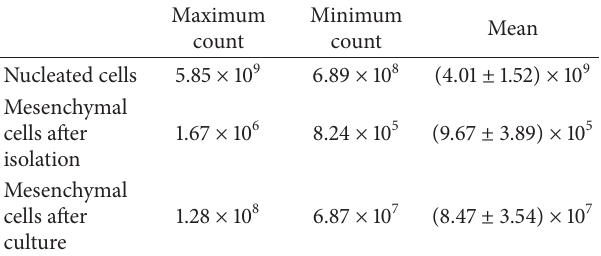
Table 3: Transplantation group cell counts (total number achieved).